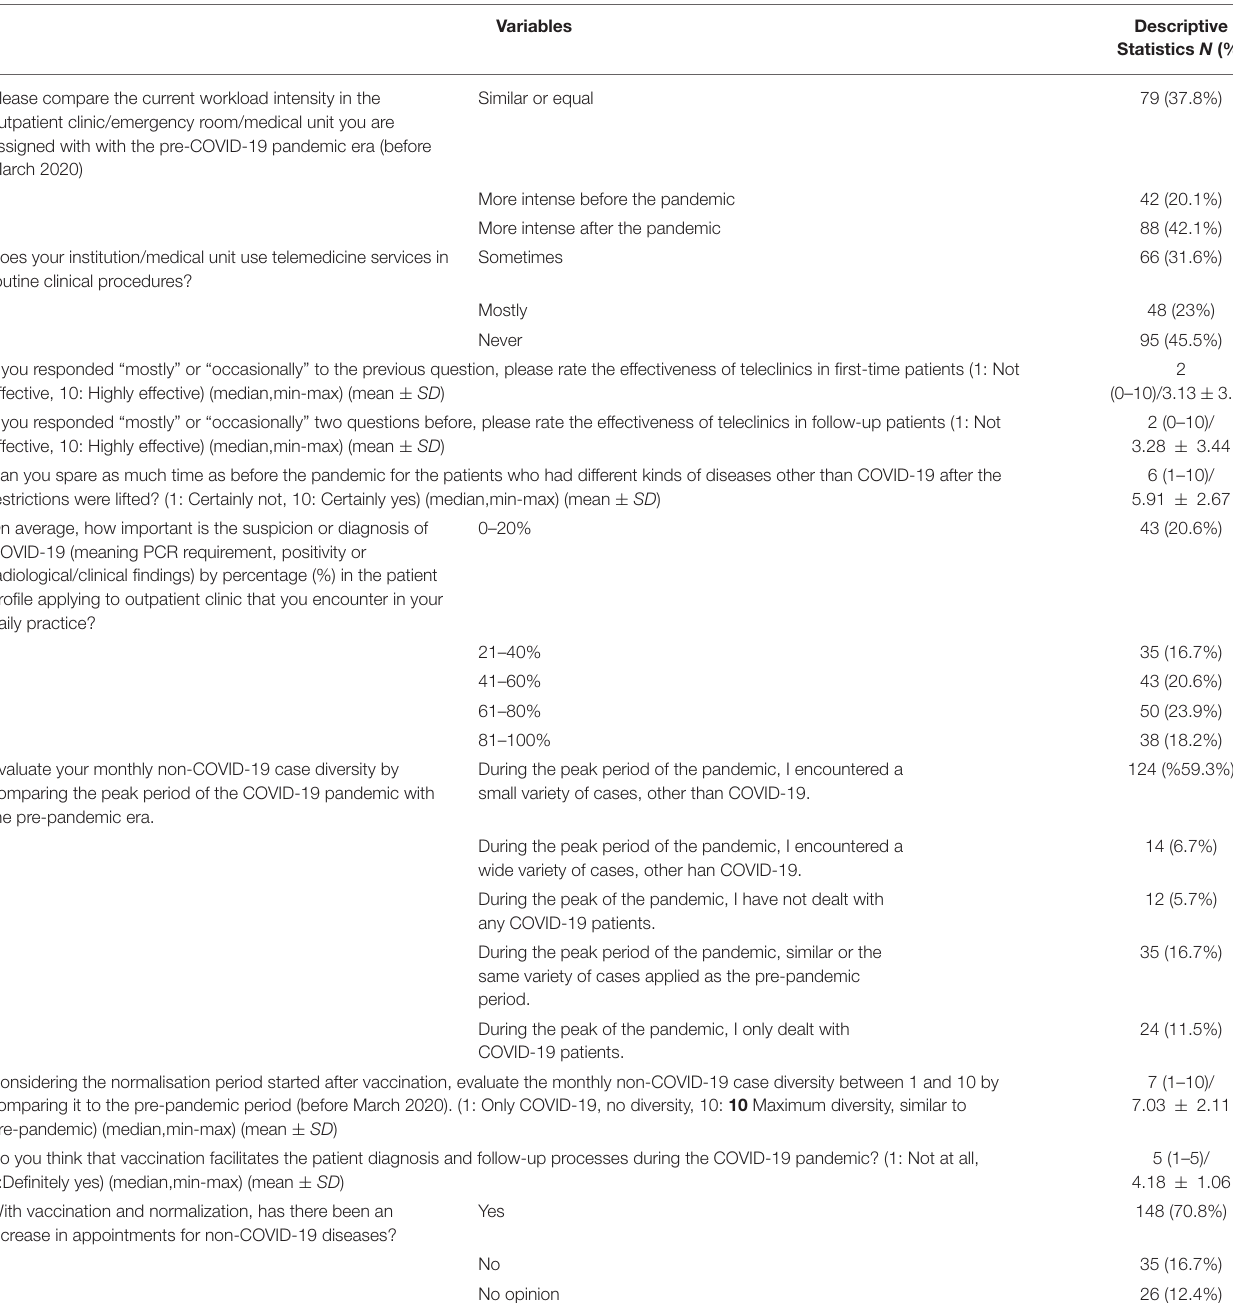
TABLE 2 | Impact of the COVID-19 pandemic, telemedicine services and COVID-19 vaccination on clinical practice during the pandemic. Variables Descriptive Statistics N (%)